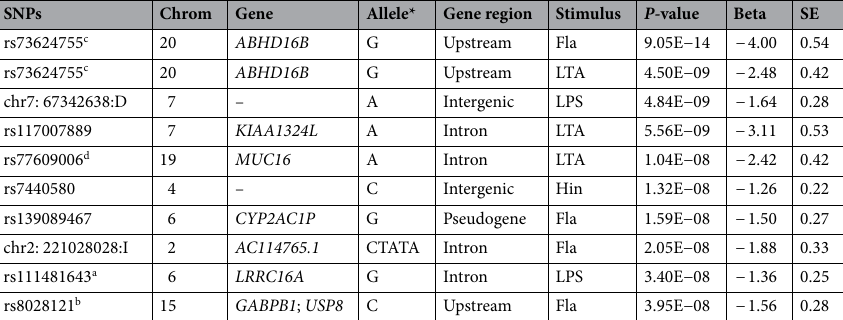
Table 2. SNPs associated with IL-6 induction in response to bacterial stimuli. *Alleles associated with lower IL-6 release. SE standard error. No loci were significantly associated with IL-6 responses to Strpn, PGN, PAM and FSL at genome-wide significance. a rs111481643 is a significant eQLT for LRRC16A in 21 cohorts (eqtlgen). b rs8028121 is a significant eQLT for GABPB1-AS in 15 cohorts (eqtlgen). c rs73624755 is an eQTL for in naïve monocytes at nominal significance (eQTL catalogue).